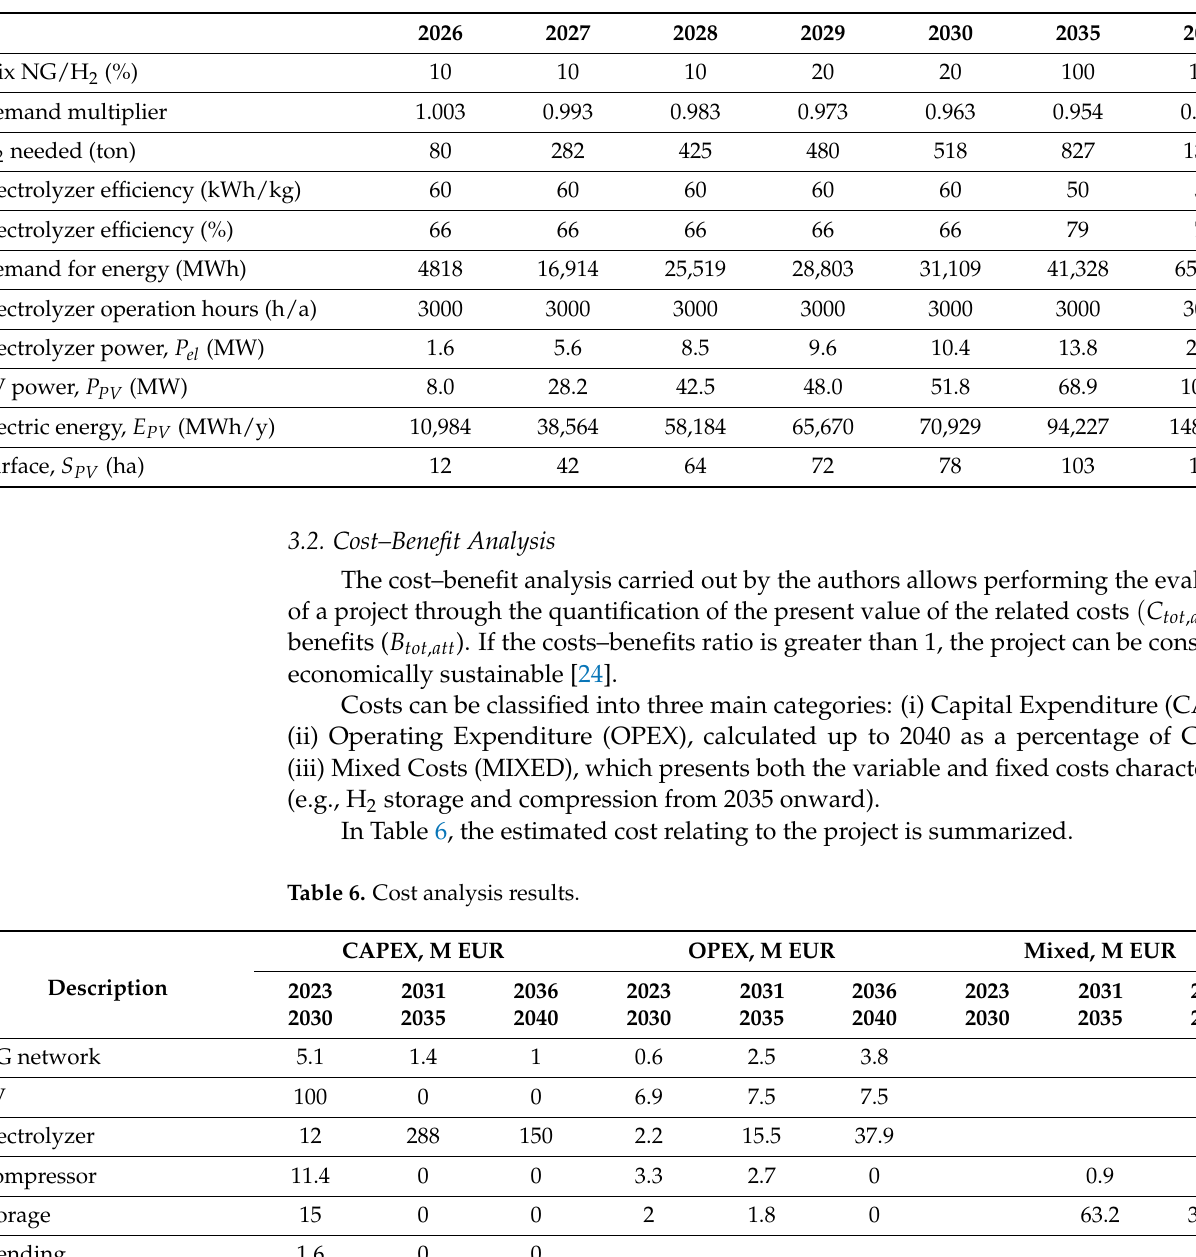
Table 5. Results of the project design phase.